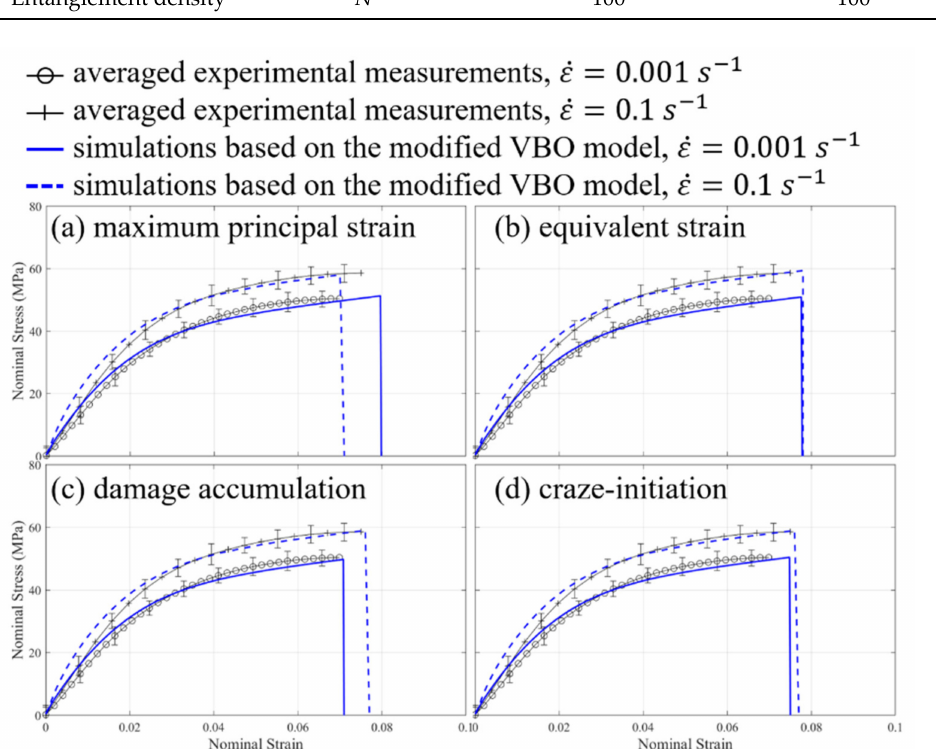
Figure 11. Comparisons of stress-stain relationships of LCP under the uniaxial compression condi- tions based on the simulations with various damage